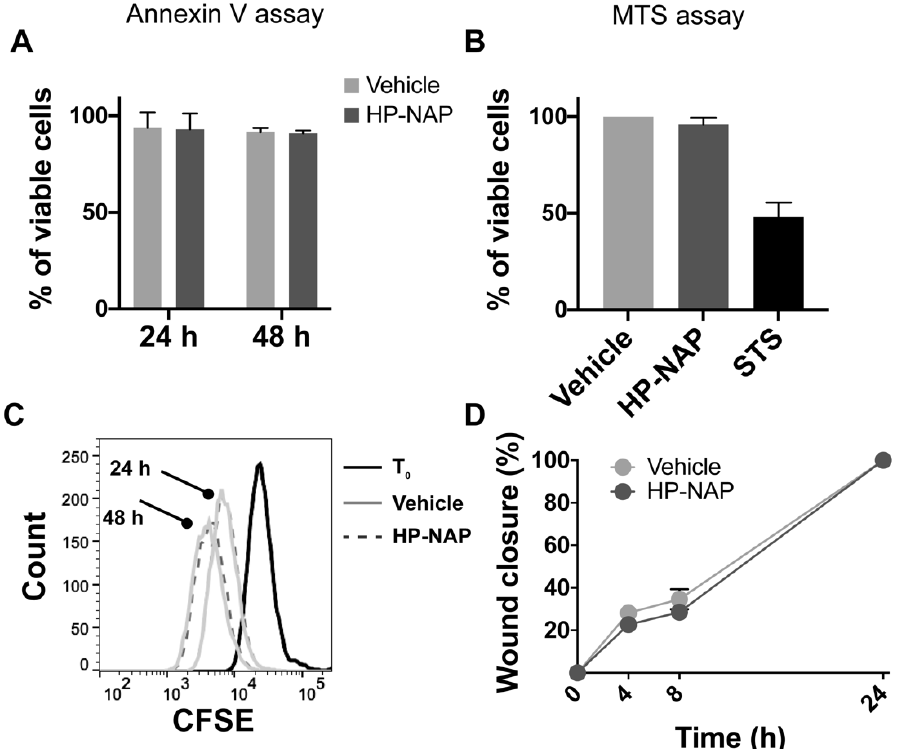
Figure 3. HP ‐ NAP has no direct effect on melanoma cells. ( A ) M121224 cells were treated with HP ‐ NAP or saline (vehicle) and after 24 and 48 h, apoptosis was evaluated by annexin V staining. ( B ) M121224 cells were treated with HP ‐ NAP, saline (vehicle) or staurosporine (STS) as positive control; cytotoxicity was evaluated by MTS assay. Values are reported as percentage of viable cells ± SEM of three independent experiments. ( C ) M121224 cells were labeled with CSFE and treated with HP ‐ NAP or saline (vehicle) for 24 and 48 h. Cells were harvested, washed, resuspended in saline and analyzed by flow cytometry. Representative histograms from two independent experiments are reported. ( D ) Cell migration was evaluated after a 24 h incubation with HP ‐ NAP in serum ‐ free RPMI (supplemented with 0.1% BSA). Cells incubated in medium with the same volume of saline were considered as control (vehicle). 0.1 × 10 6 M121224 cells were seeded in a 24 ‐ well culture dish. Scratches were created once cells reached confluence. At time zero and after 4, 8 and 24 h, wound closures were photographed under a microscope. Migration rate was expressed as percentage of wound closure (0%: T 0 after wound; 100%: completely repaired).